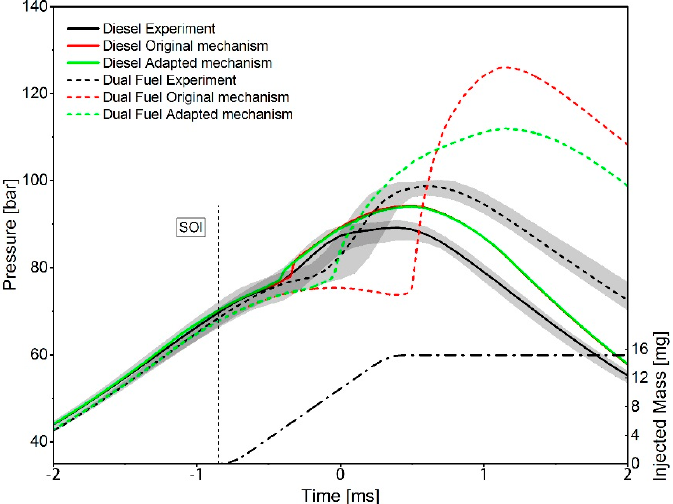
Figure 32. Comparison of measured and CFD-simulated pressure traces from an RCEM for diesel and dual fuel combustion with 20% energetic diesel share using the mechanism before and after the optimization process.